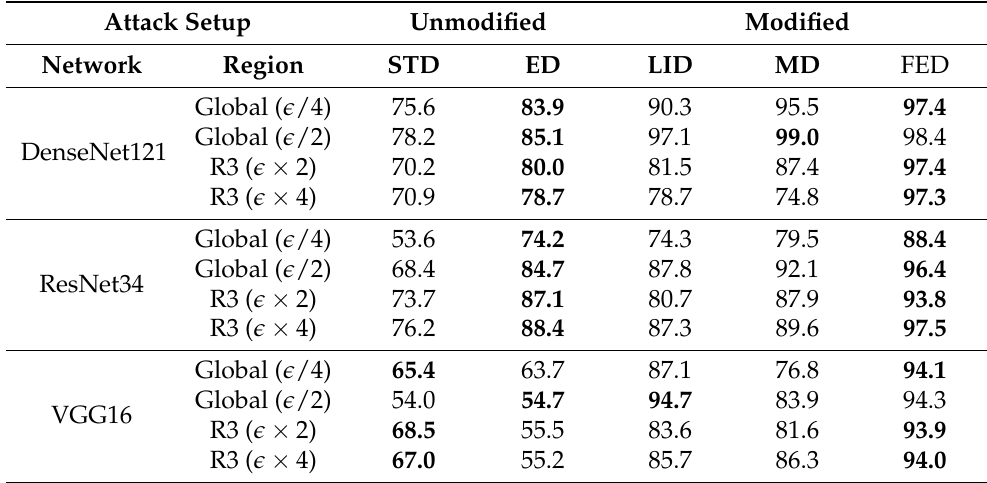
Table 7. Comparison of performance against AEs with various perturbation scales